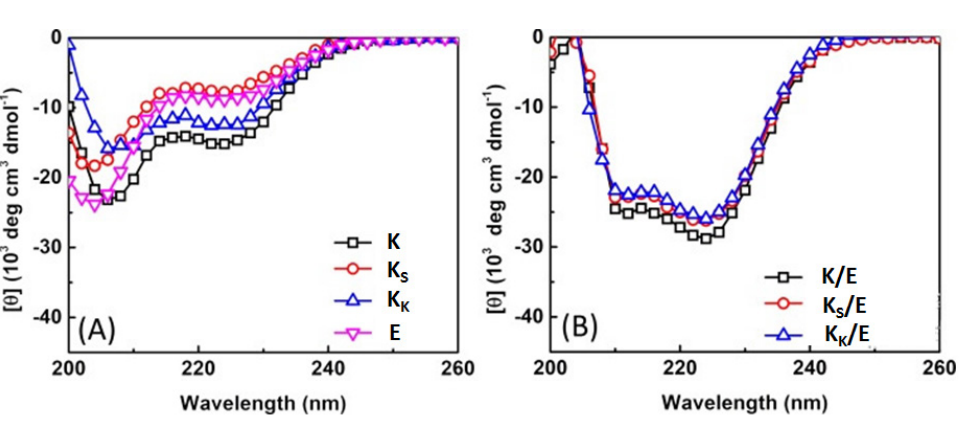
Figure 1: CD spectra of (A) peptides in PBS buffer and (B) an equimolar mixture of the K variants and E in PBS buffer. [Total peptide] = 100 uM, pH 7.4, 25 o C.